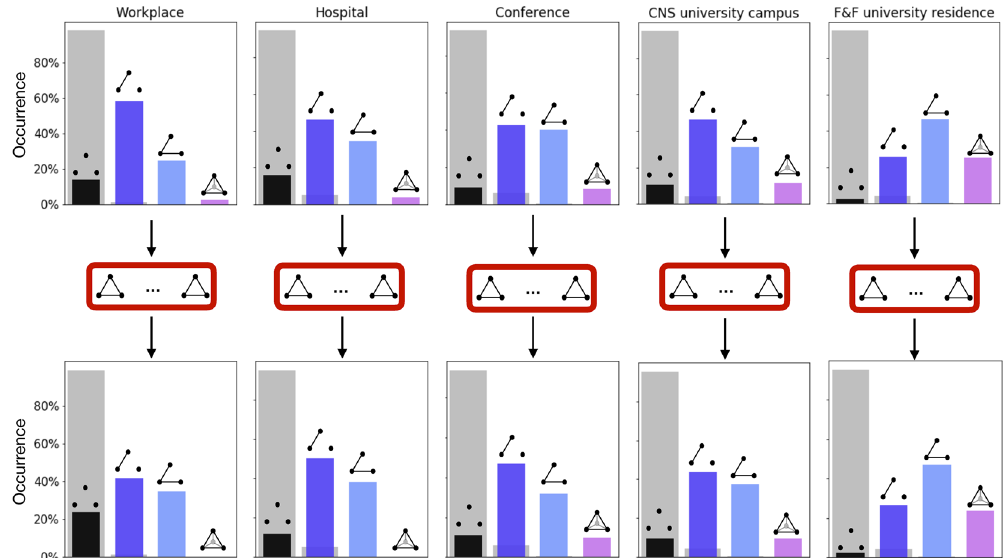
Figure 5. Transition rates of higher-order configurations. Configurations before and after a triplet event lasting at least 4500 s. Four classes of configurations are possible for three nodes that are not part of a 3-hyperedge: all disjoint (black bars), one or two pairwise interactions (dark and light blue bars) or they are all connected and part of larger interaction (purple bars). The grey bars represent the quantity obtained with a null model where temporal graphs snapshots are randomly